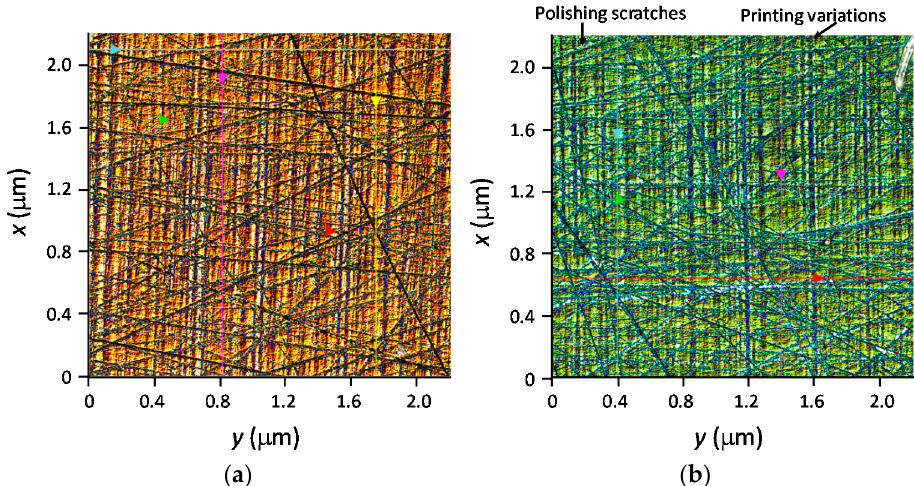
Figure 8. Surface profile maps over an area A~5 μ m 2 : ( a ) sample SC before coating and ( b ) after coating. The almost regular vertical lines are from printing whilst the haphazard solid lines are scratches arising from polishing. The colour line scans are where cross-sectional profiles at various places were taken. From these, the average roughness, R a , was calculated to be, before coating, R a (BC) = (0.170 ± 0.037) μ m and after coating, R a (AC) = (0.153 ± 0.016) μ m.